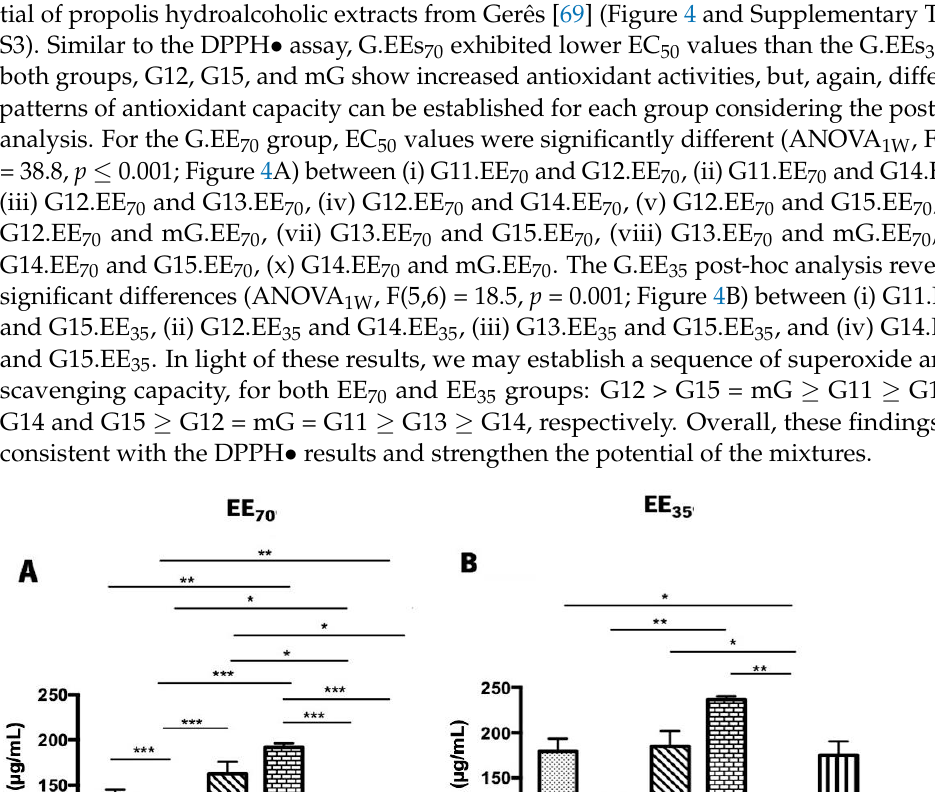
Figure 5. Capacity of G.EEs 70 (A) and G.EEs 35 (B) to inhibit heat-induced BSA denaturation. Data presented as mean ± SEM (*0.05 > p ≥ 0.01, ** 0.01 > p ≥ 0.001, *** p < 0.001). (G: Gerês; mG: a mixture of propolis samples from Gerês; ASA: acetylsalicylic acid). Curiously and contrary to the tendency observed for the antioxidant potential, G.EEs 35 exhibited higher inhibition of BSA denaturation than the corresponding samples in the EE 70 group. Nevertheless, G14 is the propolis sample with the highest anti-inflam- matory capacity (Supplementary Table S4) regardless the extraction solvent. The mixtures outperformed almost every individual G.EE 35 , as well as G12 and G15 in the case of the EE 70 group, in terms of anti-inflammatory efficacy (Supplementary Table S4).